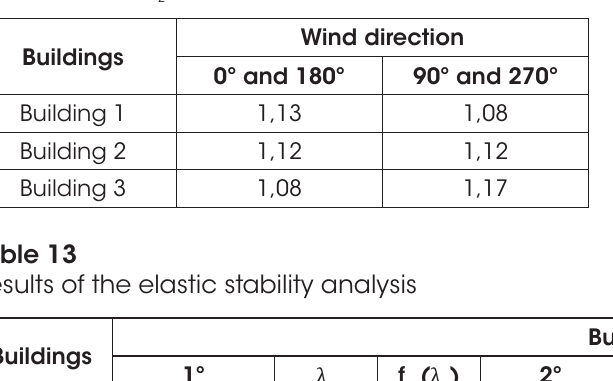
Results for the